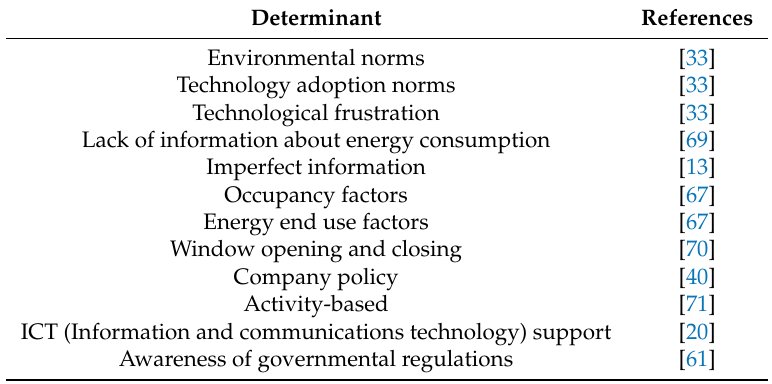
Table 6. Contextual determinants in public